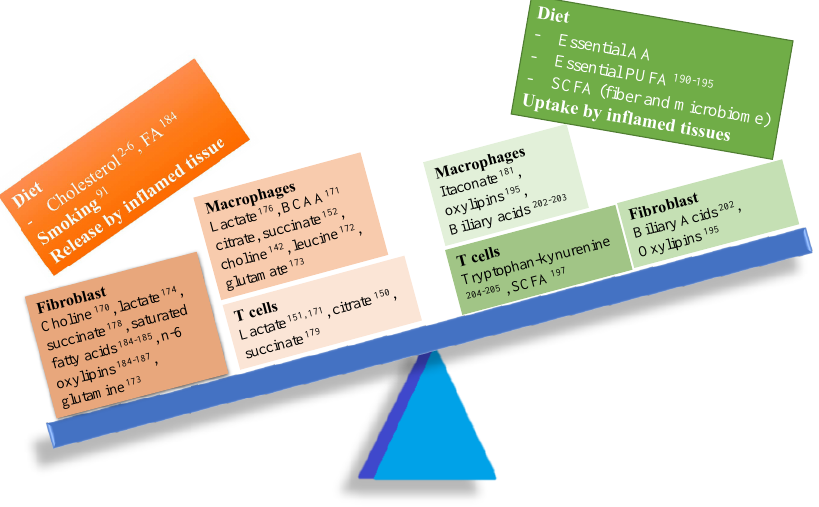
Figure 4. Imbalance between pro- and anti-inflammatory metabolites in RA. Several pro-inflammatory metabolites (left side of the balance) might play a key role in RA pathogenesis modulating the function of several cell types involved in synovial inflammation.